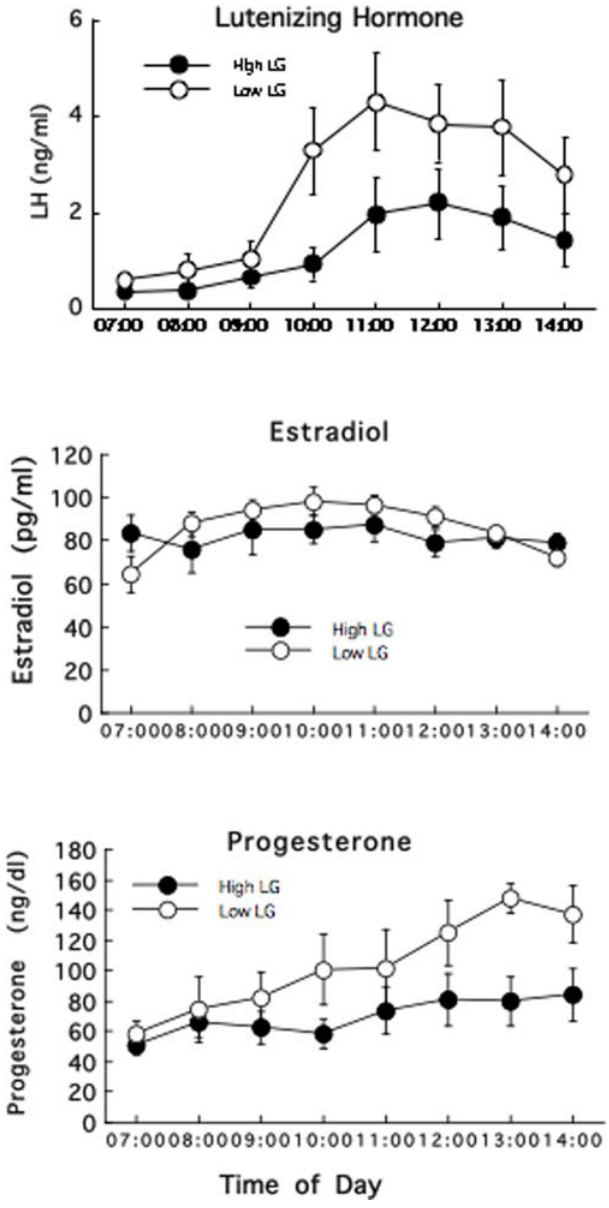
Figure 2. Hormonal levels during proestrus. Mean 6 SEM plasma levels of lutenizing hormone (LH), estradiol and progesterone in the adult offspring of High or Low LG mothers (n=8–10/group) over the day of proestrus (lights off at